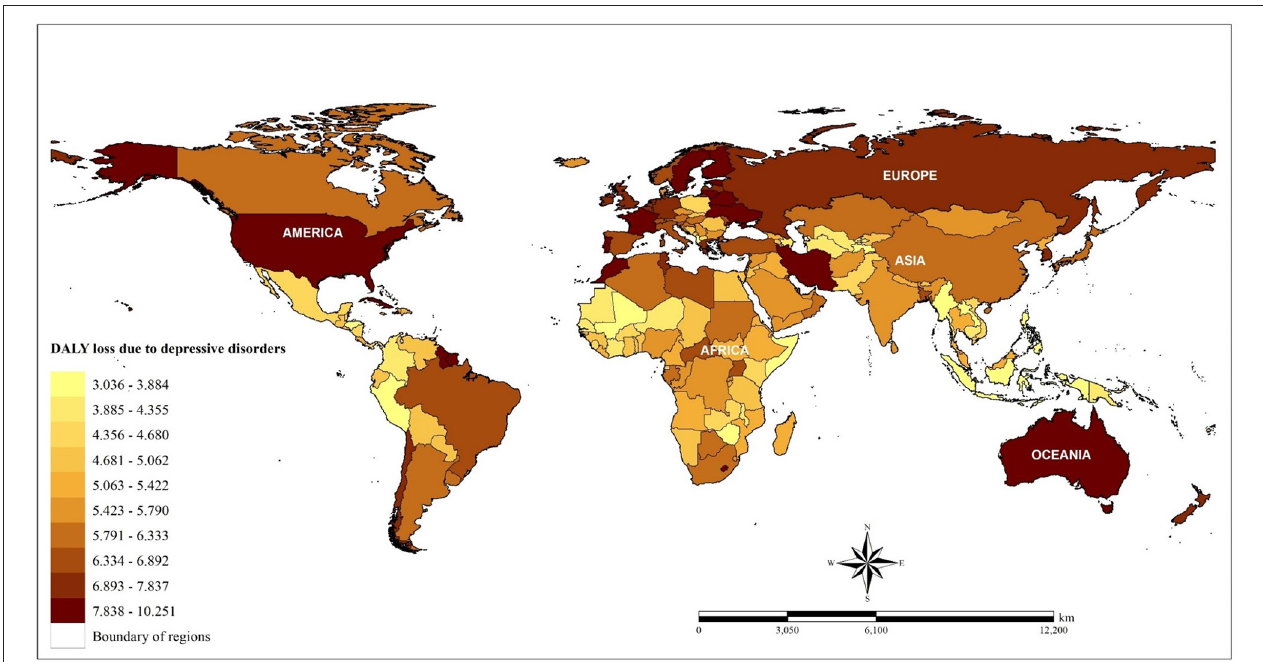
FIGURE 1 | Spatial distribution of DALY loss due to depressive disorders across countries based on the average value from four study periods (2000, 2010, 2015,